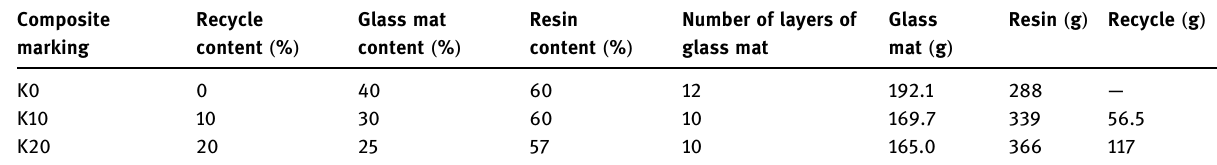
Table 1: Percentage composition of composite materials used in the research [ 6,8 ]